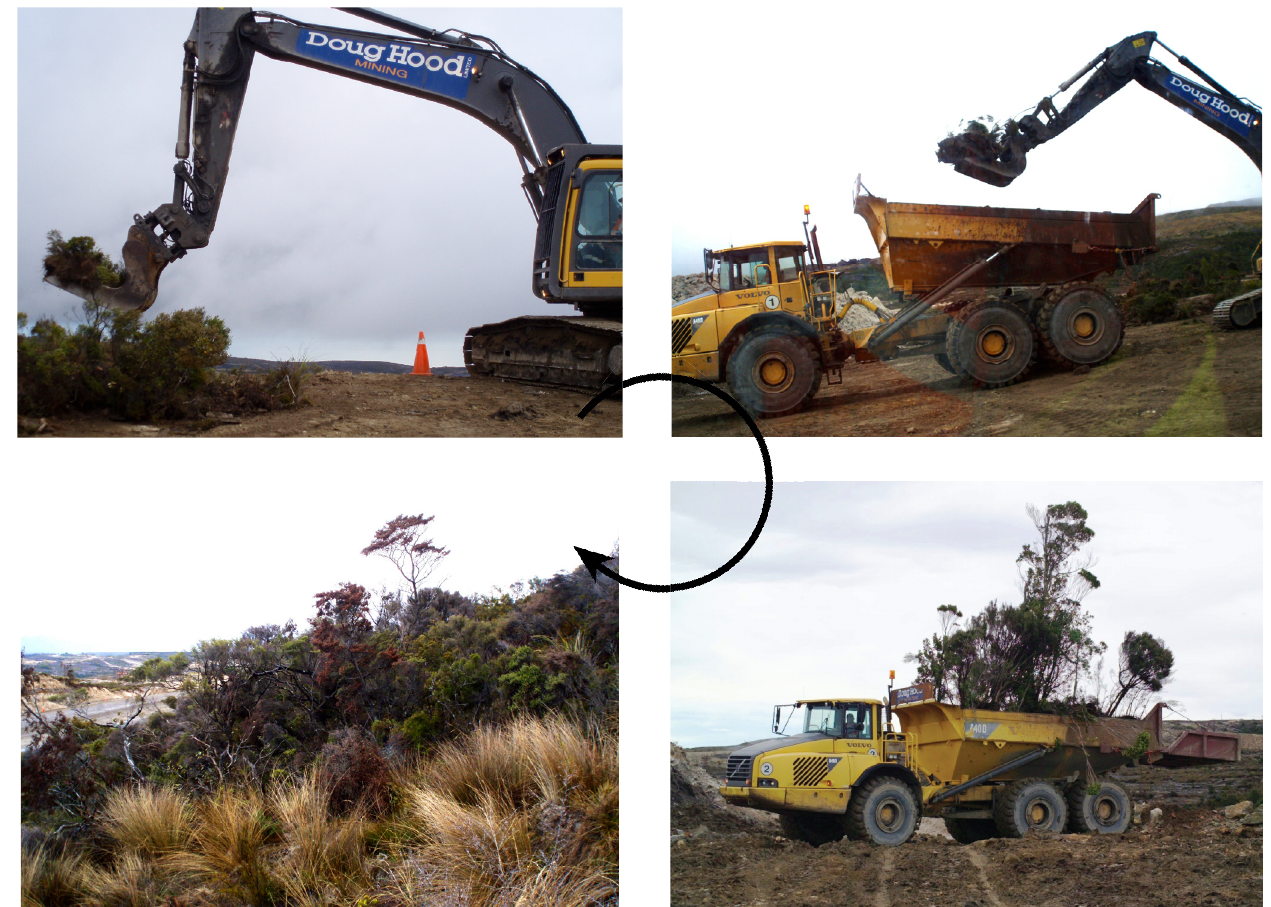
Figure 1. Vegetation direct transfer of native alpine forest at the Stockton opencast coal mine (New Zealand). Clockwise: pieces of land comprising vegetation, roots and soil are cut; soil and vegetation sods are loaded on a truck and transported to the receptor site; the landscape jigsaw is then reconstituted with minimum gaps between the sods to recreate a continuous habitat. Credits: Stéphane Boyer and Solid Energy New Zealand Ltd.